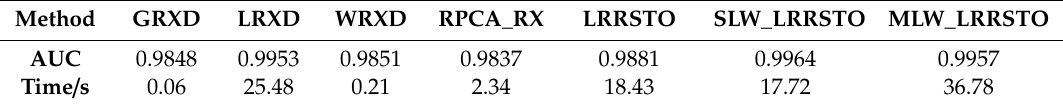
Figure 9. ROC evaluation of the different methods for the HYDICE_urban dataset. Table 4. AUC values for the different detectors with the HYDICE_urban dataset.